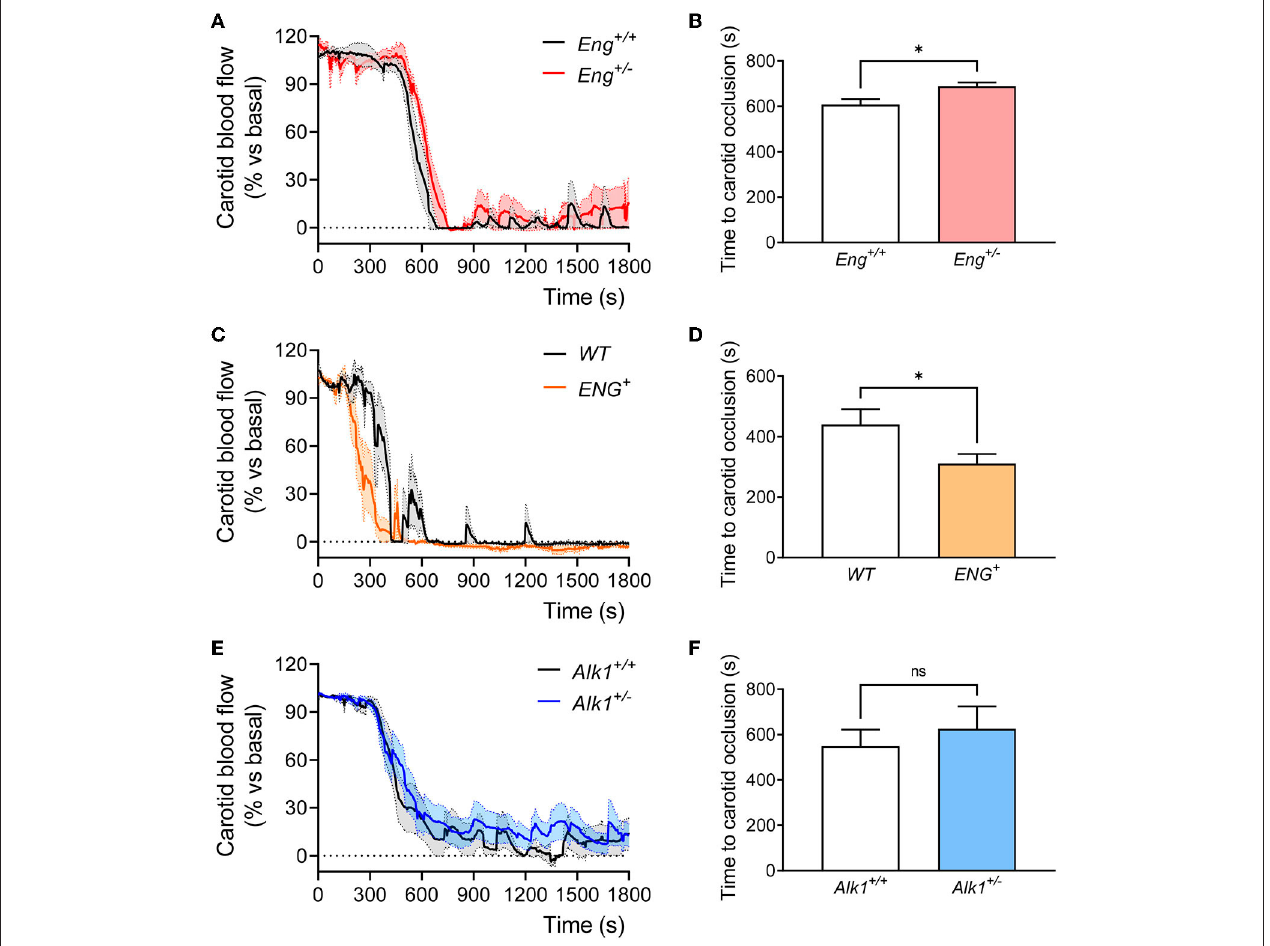
FIGURE 5 | (A) Evolution of carotid blood flow after application of FeCl 3 in carotid arteries of Eng + / + ( n = 5) and Eng + / − ( n = 5) mice. Percentage of baseline blood flow is represented as the mean of all mice (thick line) and the standard error of the mean (dotted line and shaded area). (B) Time to complete a stable carotid occlusion after FeCl 3 administration in carotids of Eng + / − mice ( n = 5) and their controls ( n = 5). (C) Evolution of carotid blood flow after application of FeCl 3 in carotid arteries of WT ( n = 5) and ENG + ( n = 6) mice. Percentage of baseline blood flow is represented as the mean of all mice (thick line) and the standard error of the mean (dotted line and shaded area). (D) Time to complete a stable carotid occlusion after FeCl 3 administration in carotids of ENG + mice ( n = 6) and their WT controls ( n = 5). (E) Evolution of carotid blood flow after application of FeCl 3 in carotid arteries of Alk1 + / + ( n = 10) and Alk1 + / − ( n = 12) mice. Percentage of baseline blood flow is represented as the mean of all mice (thick line) and the standard error of the mean (dotted line and shaded area). (F) Time to complete a stable carotid occlusion after FeCl 3 administration in carotids of Alk1 + / − mice ( n = 12) and their controls ( n = 10). Results were considered statistically significant if p < 0.05 (ns: non-significant; *: p < 0.05; **: p < 0.01; ***: p < 0.001; ****: p <